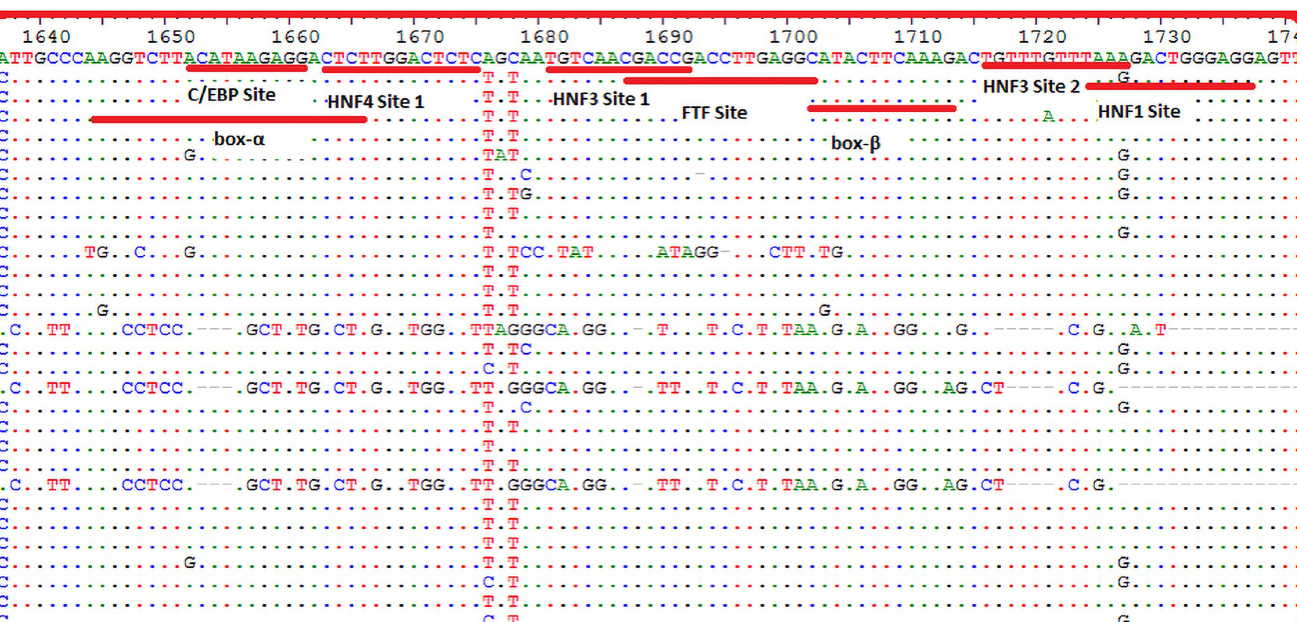
Fig 5. Mutations in different transcriptional factors affecting enhancer II activity.